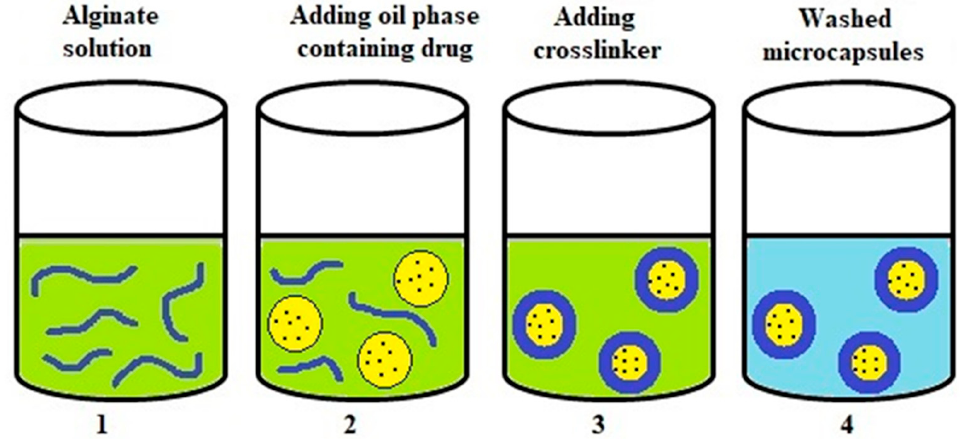
Figure 6. Schematic representation of microcapsule formation. 1. Alginate solution. 2. The oil phase, containing the encapsulating ingredients, is emulsified in the alginate solution. 3. The addition of CaCl 2 solution and formation of alginate microcapsules at the interface of the oil droplets. 4. The solvent is removed, and the microcapsules are isolated and washed.